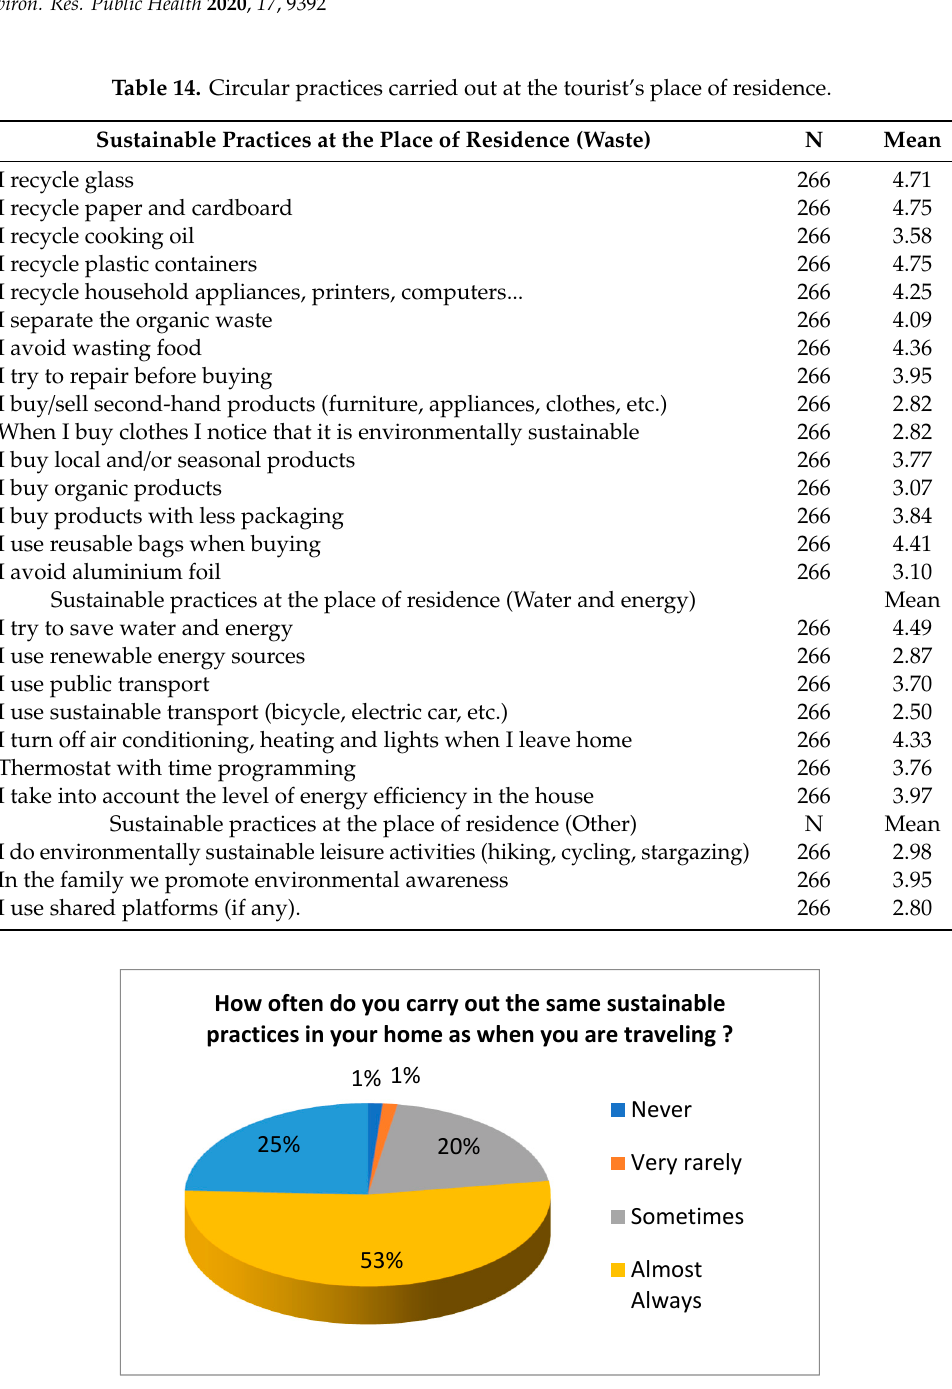
Figure 1. How often tourists carry out the same circular practices in their place of residence as when travelling.